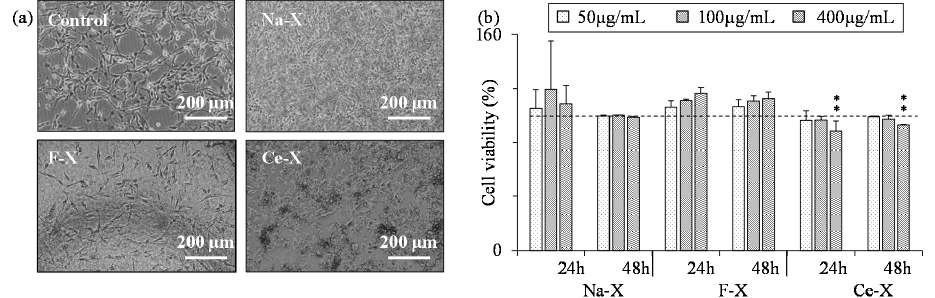
control group (0 µ g/mL)). Molecules 2018 , 23 , x FOR PEER REVIEW